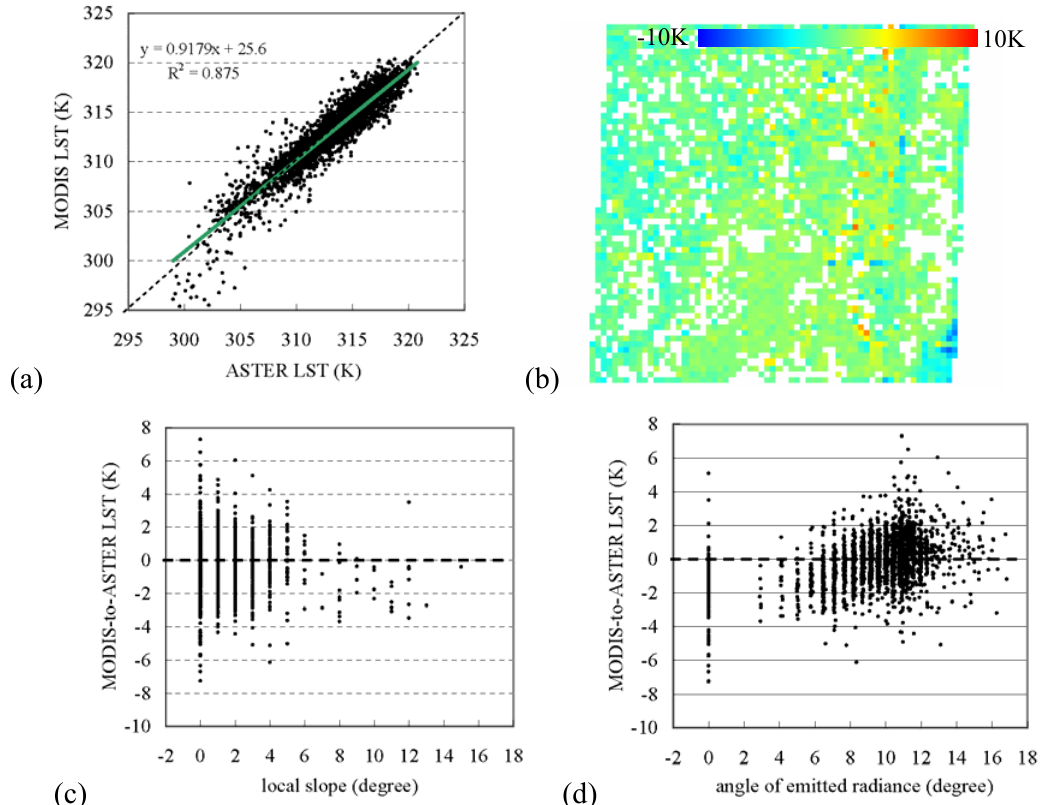
Figure 5 . (a) ASTER LST versus rectified MODIS LST with terrain correction, (b) spatial distribution of ASTER-to-MODIS LST discrepancy, (c) local slope versus ASTER-to- MODIS LST, and (d) angle of emitted radiance versus ASTER-to-MODIS